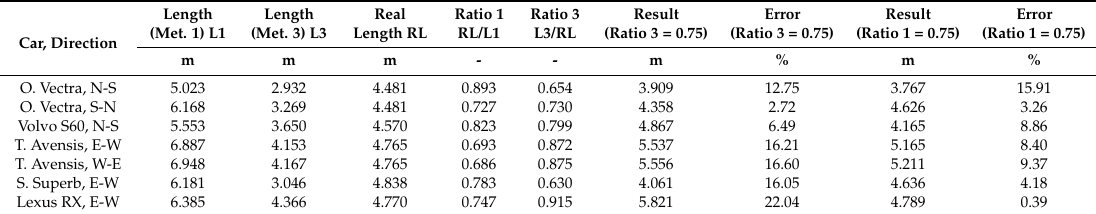
Table 4. The average length measurement values yielded using the methods 1 and 3, real car lengths, ratios of the lengths, errors. Common ratio values 0. 75 were assumed for all car brands.